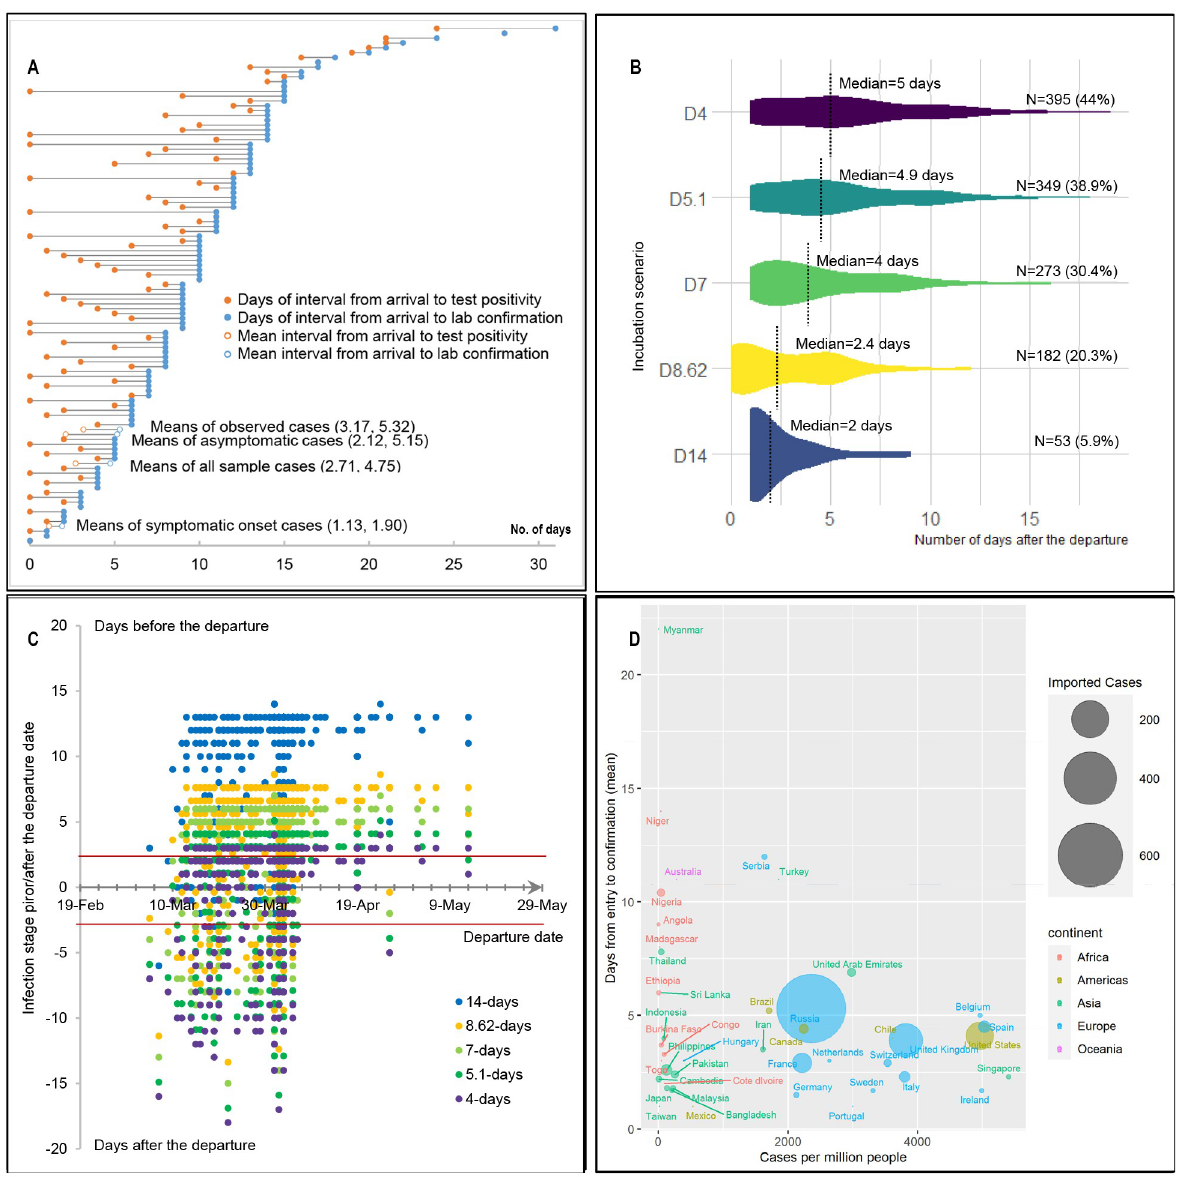
Fig 5. Characteristics of the imported COVID-19 cases. (A) reveals the distributions of the periods from the port of entry to testing positivity and lab confirmation, respectively, based on the sample data. The mean interval from arrival to test positivity and to a lab confirmation of the four groups of cases are shown in the parenthesis. (B) illustrates the time interval from entry to a case confirmation and the sample distribution based on the assumption of different incubation periods. (C) reflects the estimated temporal distribution of possible infection dates of the samples, based on the date of departure, date of confirmation, and assumptions of different incubation periods. (D) shows the correlation between the average time of confirmation of cases and the epidemic risk of different